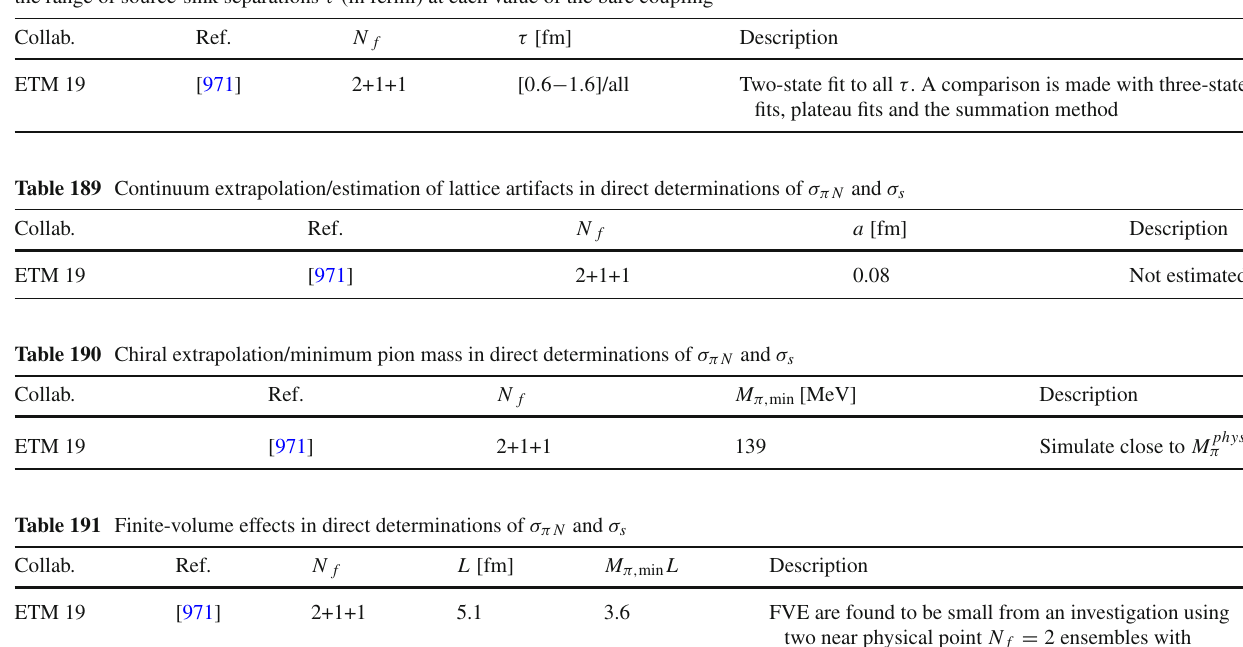
and g q . The comma-separated list of numbers in square brackets denote A T